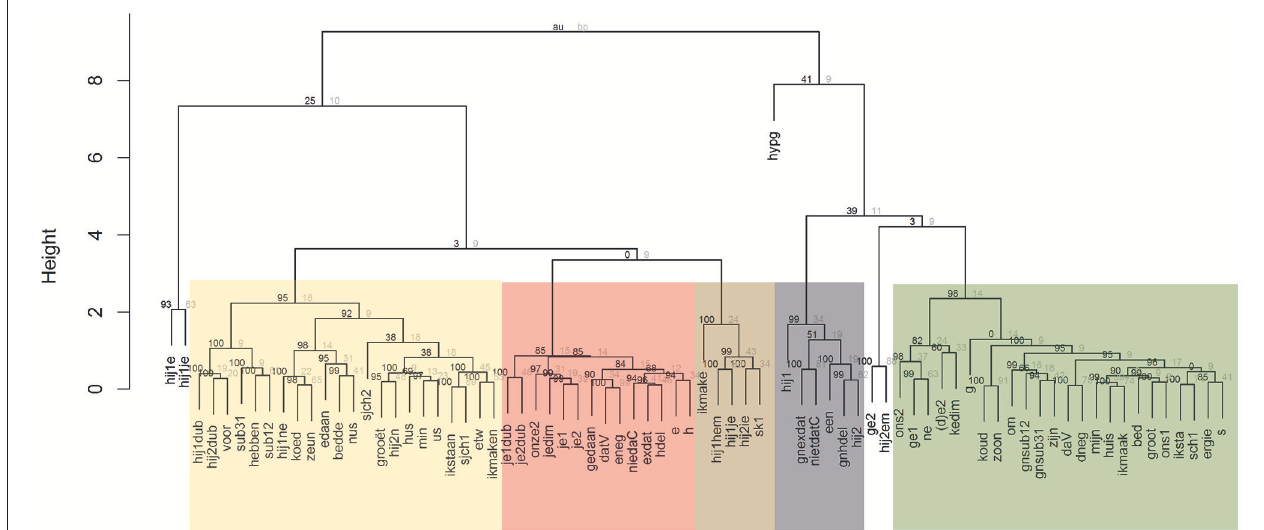
FIGURE 3 | Dendrogram with variants attested in Ieper; cluster analysis on the basis of the four-dimensional coordinates for the different variants in a correspondence regression (bootstrap resampling: n = 5,000) 16